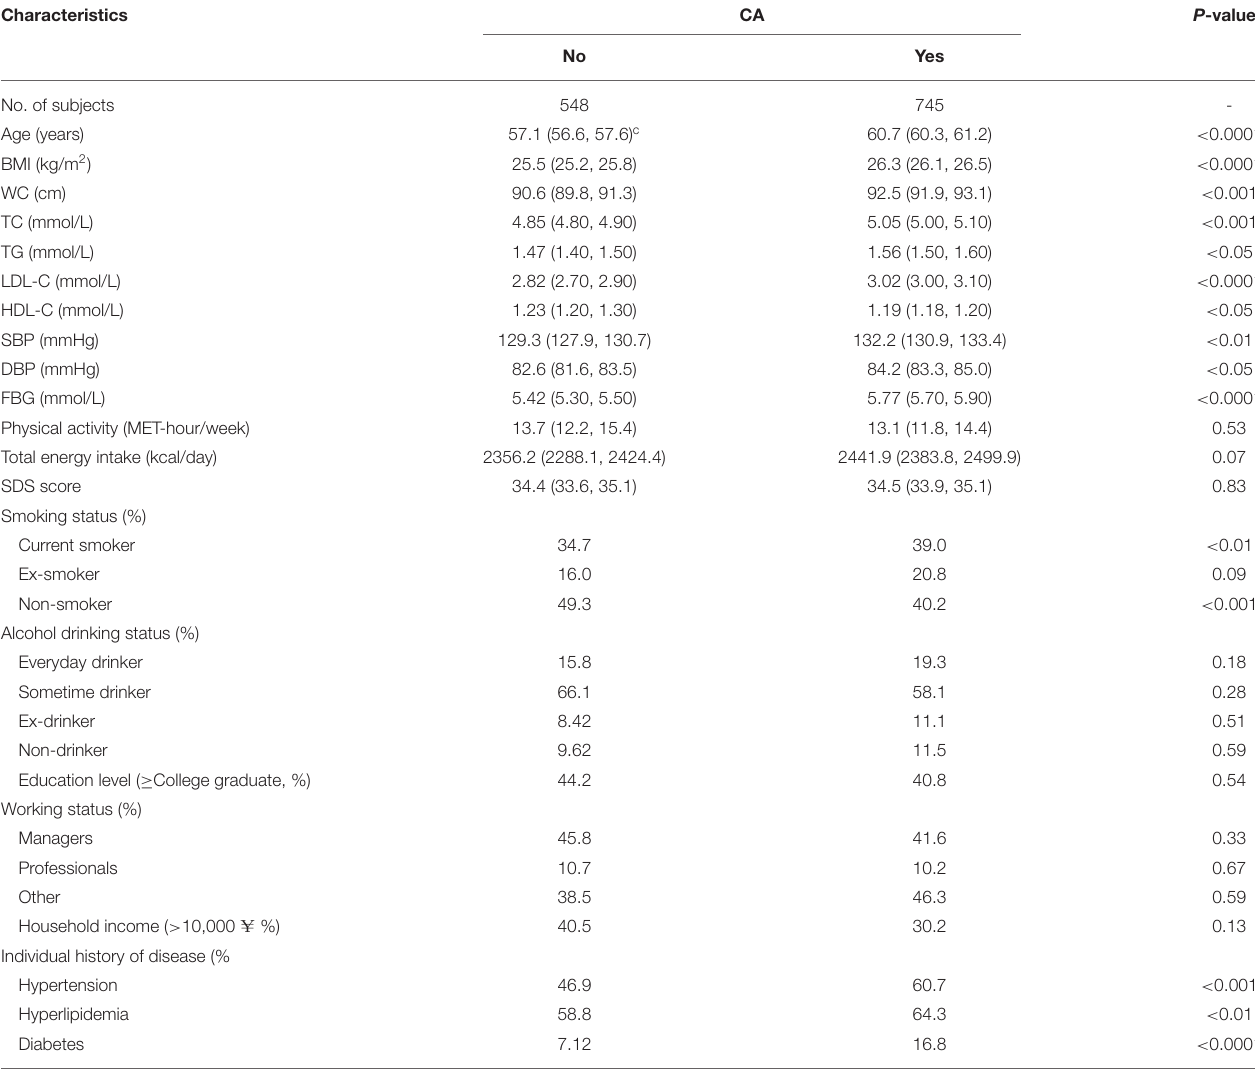
TABLE 1 | Age-adjusted baseline characteristics of study participants by the prevalence of CA in men ( n = 1,293) a .